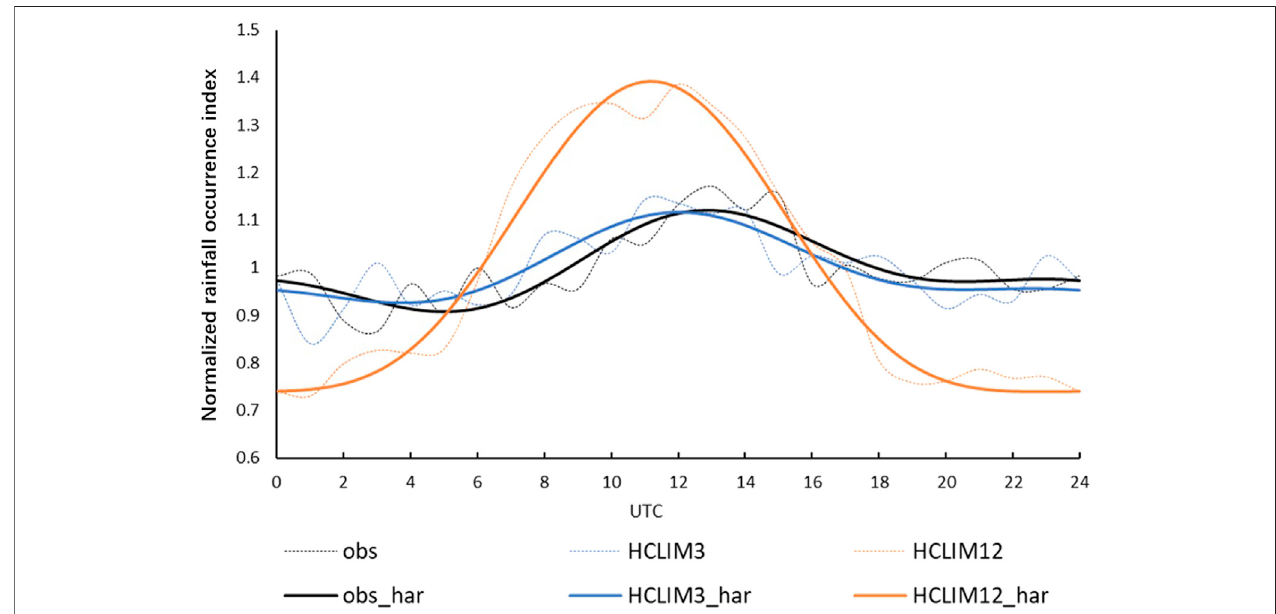
FIGURE 3 | Example of empirical cycle (dotted lines) and smoothed cycle by harmonic analysis (solid lines) for rainfall occurrence in station HEL.